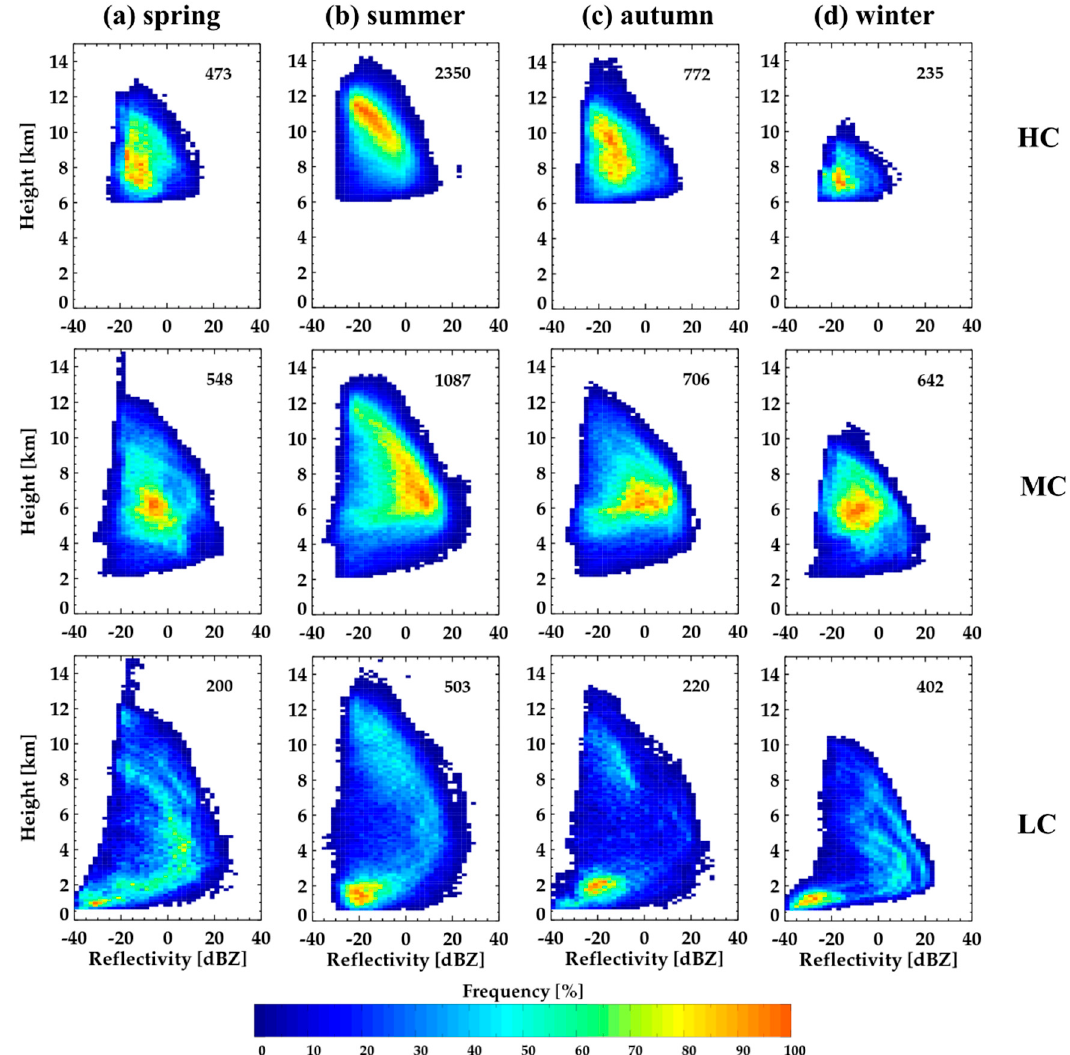
Figure 12. Seasonal CFADs of reflectivity for the different cloud types: (upper) HC, (middle) MC, and (lower) LC. ( a ) Spring, ( b ) summer, ( c ) autumn, and ( d ) winter.